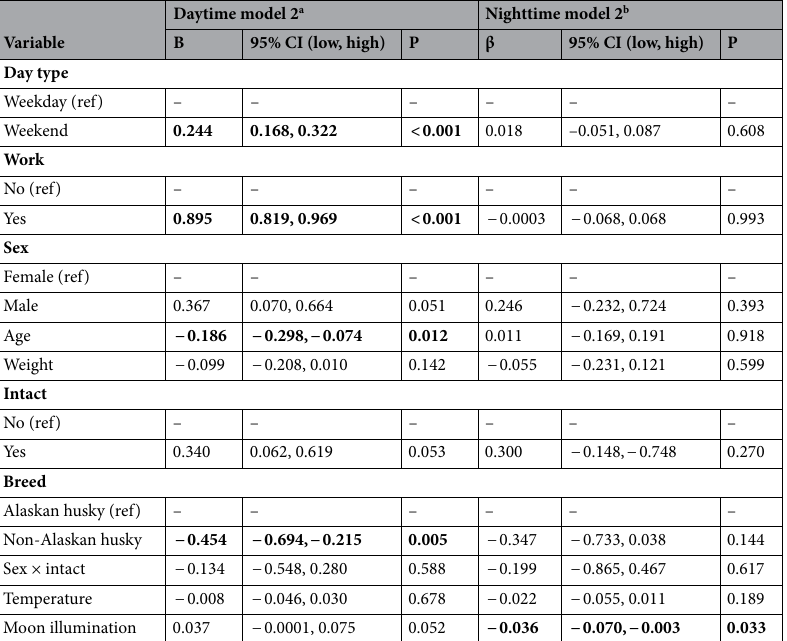
Table 2. Summary of multivariable approach using linear mixed-effects models in 23 Canmore dogs. Daytime model analysis of MotionWatch activity counts from 6:00 a.m. to 8:59 p.m. while nighttime model includes analysis of MotionWatch activity counts from 9:00 p.m. to 5:59 a.m. a Overall model fit compared to the null model: N = 690, χ 2 = 561.5, P < 0.001. Marginal R 2 = 0.598, conditional R 2 = 0.684. b Overall model fit compared to the null model: N = 690, χ 2 = 15.07, P = 0.130. Marginal R 2 = 0.152, conditional R 2 = 0.562. Significant